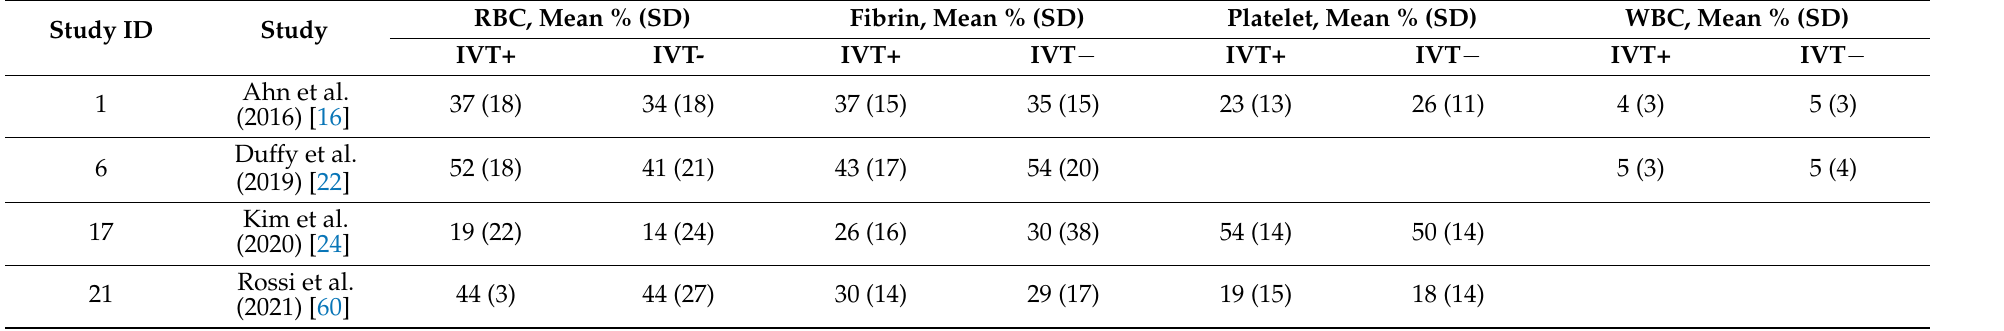
Table 5. Clot component fractions and Bridging